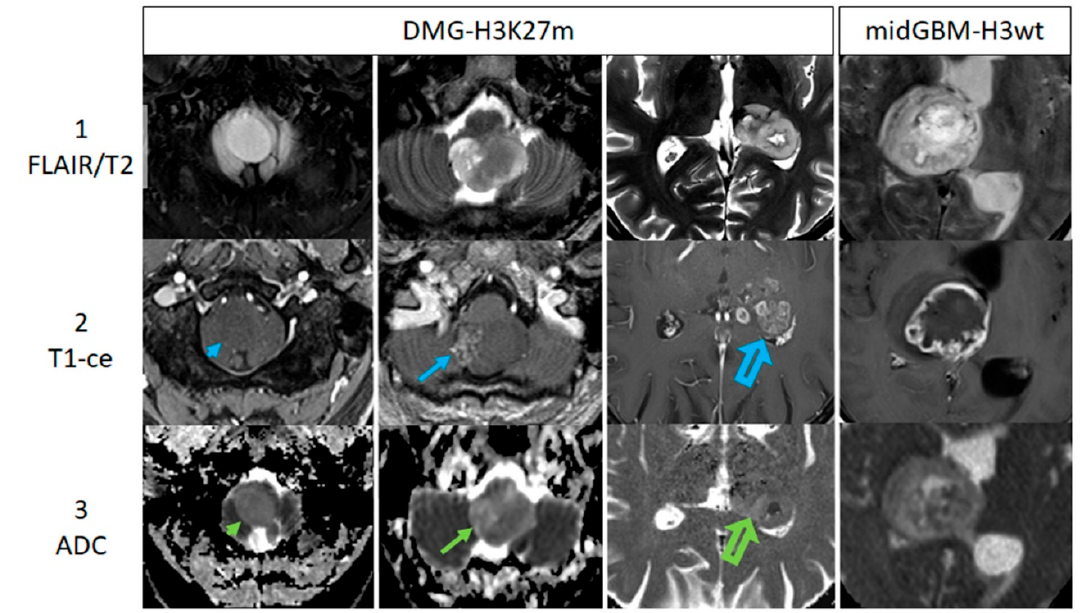
Figure 2. This figure displays examples of MR imaging findings including DWI/ADC. The cases of four patients with midline gliomas are shown in columns from left to right (row 1 presenting FLAIR/T2w-images, row 2 representing ce-T1w images, and row 3 showing ADC maps). The first three columns present DMGs with increasing contrast enhancement from left to right: no enhancement (blue arrowhead), low enhancement (blue arrow) and strong enhancement (blue open arrow). The fourth column shows a case of a midline glioblastoma (midGBM-H3wt). Corresponding ADC-maps are shown in row 3, indicating the variance of inhomogeneity (green arrowhead/arrows pointing at the tumor).